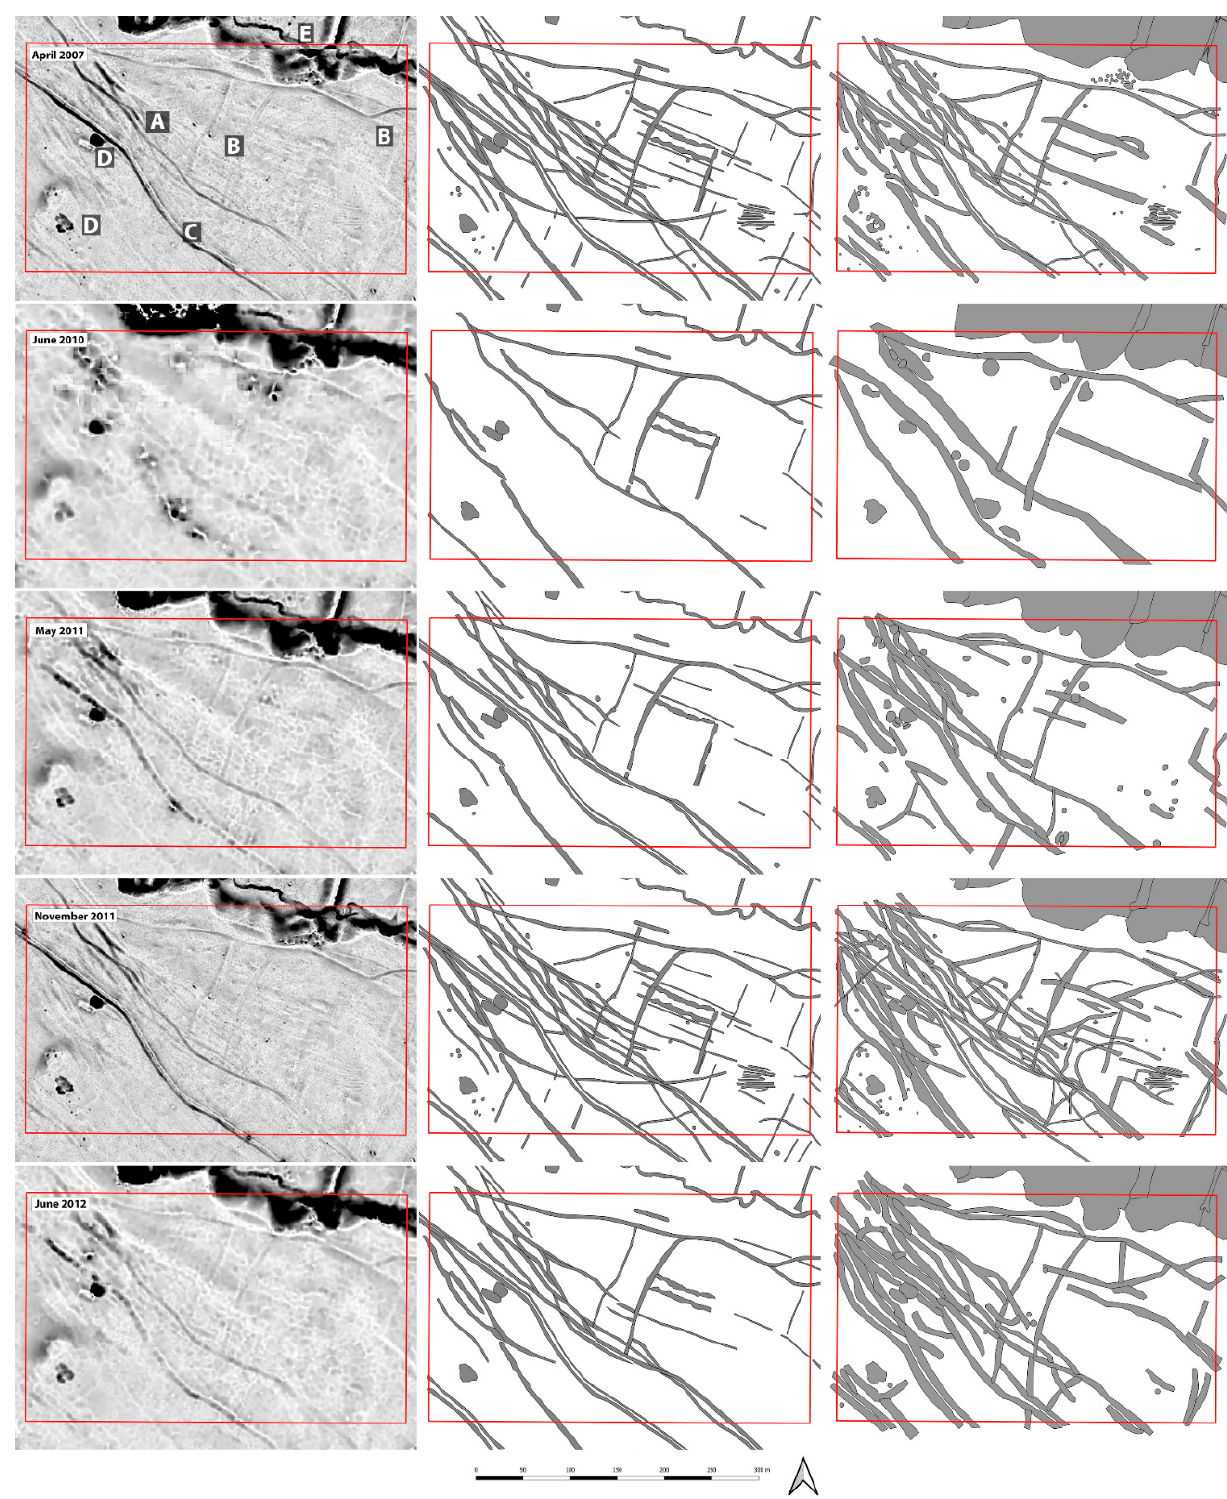
Figure 14. Area 3. The columns represent a visualisation of the dataset using positive openness with colour gradient black to white, stretch to min–max min. 1.41–max. 1.58 ( left ), results of the “copied interpretation” ( centre ), and results of the ”individual interpretation” ( right ). The rows correspond to the individual datasets as indicated for each row in the left image. The red box represents the boundary of the sample area. The letters in the upper left image refer to the text.